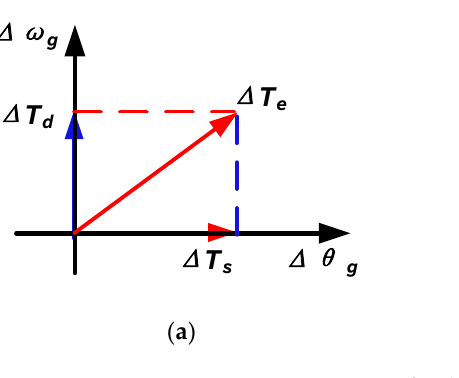
Figure 5. Diagram for demonstrating concepts of damping torque and synchronizing torque: ( a ) phasor diagram of damping and synchronizing torque; ( b ) impacts of damping and synchronizing torques on internal voltage stability.